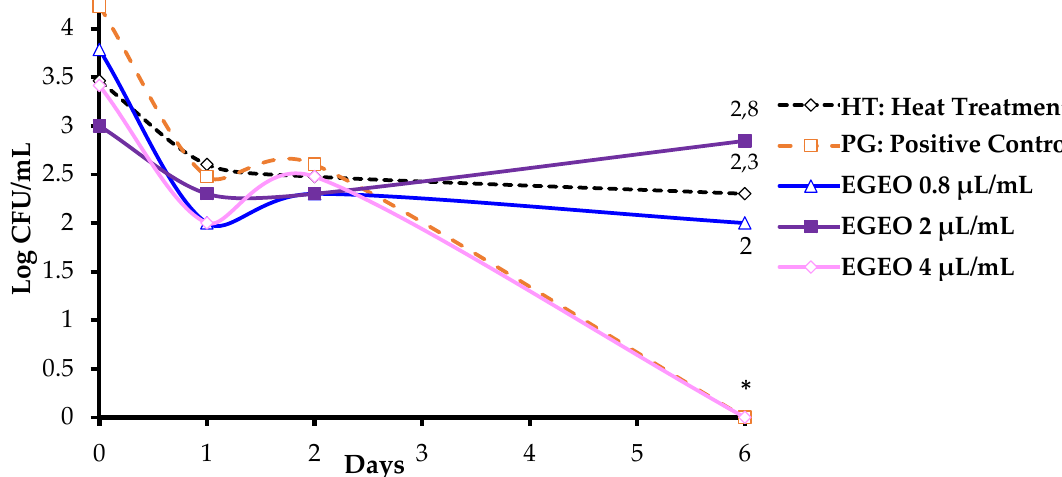
Figure 2. Effect of different doses of EGEO (0.8, 2 and 4 µL/mL) on the viability of Saccharomyces cerevisiae cells in Orangina beverage during storage. The fungal growth was followed up to 6 days after the application. HT: Heat treatment at 70 °C for 2 min; PG: Positive control or juice with synthetic antimicrobial additives (sodium benzoate and potassium sorbate); EGEO: Eucalyptus globulus essential oil; CFU: Colony-forming unit. * significant difference ( p < 0.05) according to ANOVA one-way analysis followed by Tukey’s post hoc multiple comparison tests.